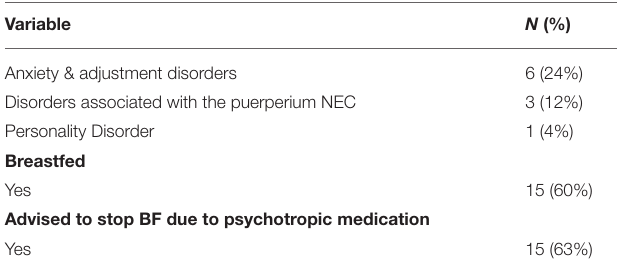
TABLE 3 | Socio demographic and clinical characteristics of qualitative sample ( n =